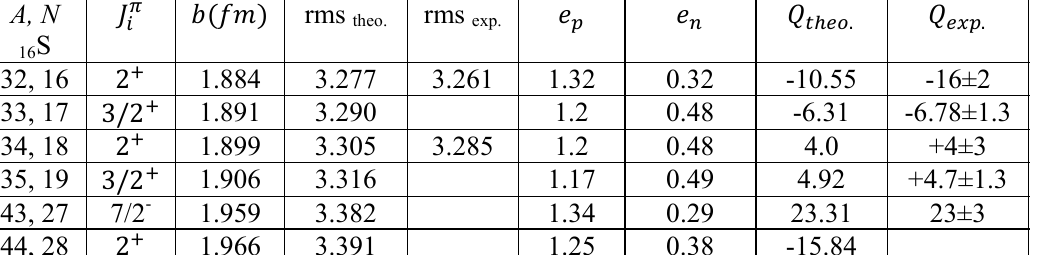
Table 4: Quadrupole moments in units of (cid:2187) (cid:2188)(cid:2195) (cid:2779) calculated with harmonic oscillator (HO) potential for Sulfur (S) isotopes (Z = 16). Effective proton and neutron charges are deduced from the core polarization calculation. Experimental quadrupole moments are taken from Ref. [18].